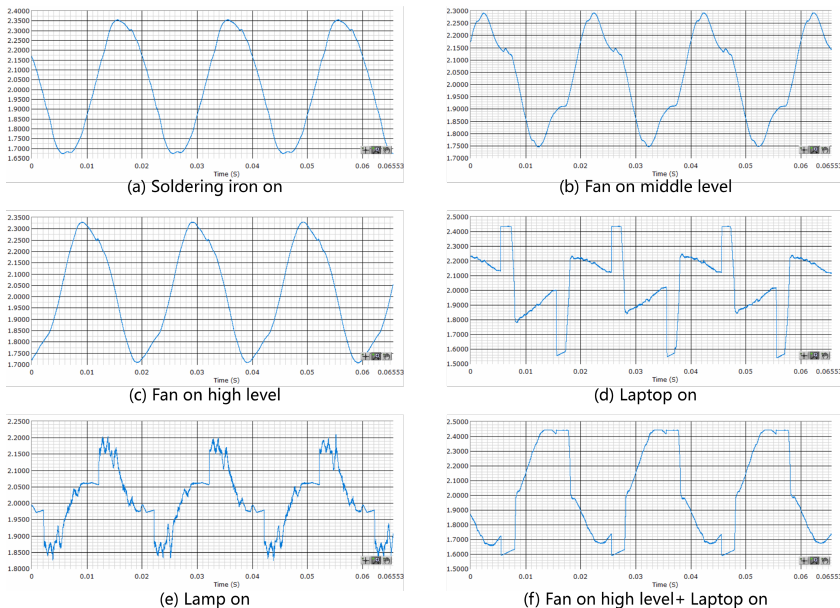
Figure 1. Different current waveforms for different appliances sampled at 1